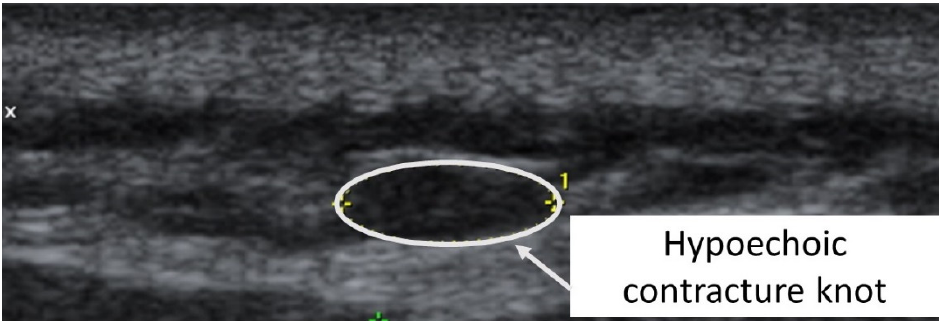
Figure 5. Ultrasound imaging assessment of the left upper trapezius muscle showing a palpable contracture knot as a hypoechoic (hyperperfused) area.